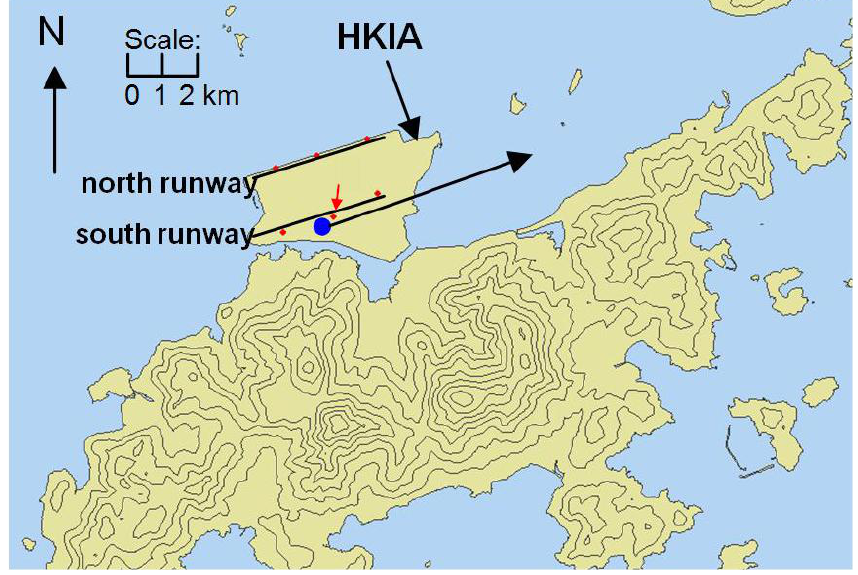
Figure 1. Location of the LIDAR (blue dot) and the direction of the LIDAR RHI scans considered in the present study. The red dots indicate the locations of the forward scatter sensors along the two runways. The forward scatter sensor used in the study is indicated by a red